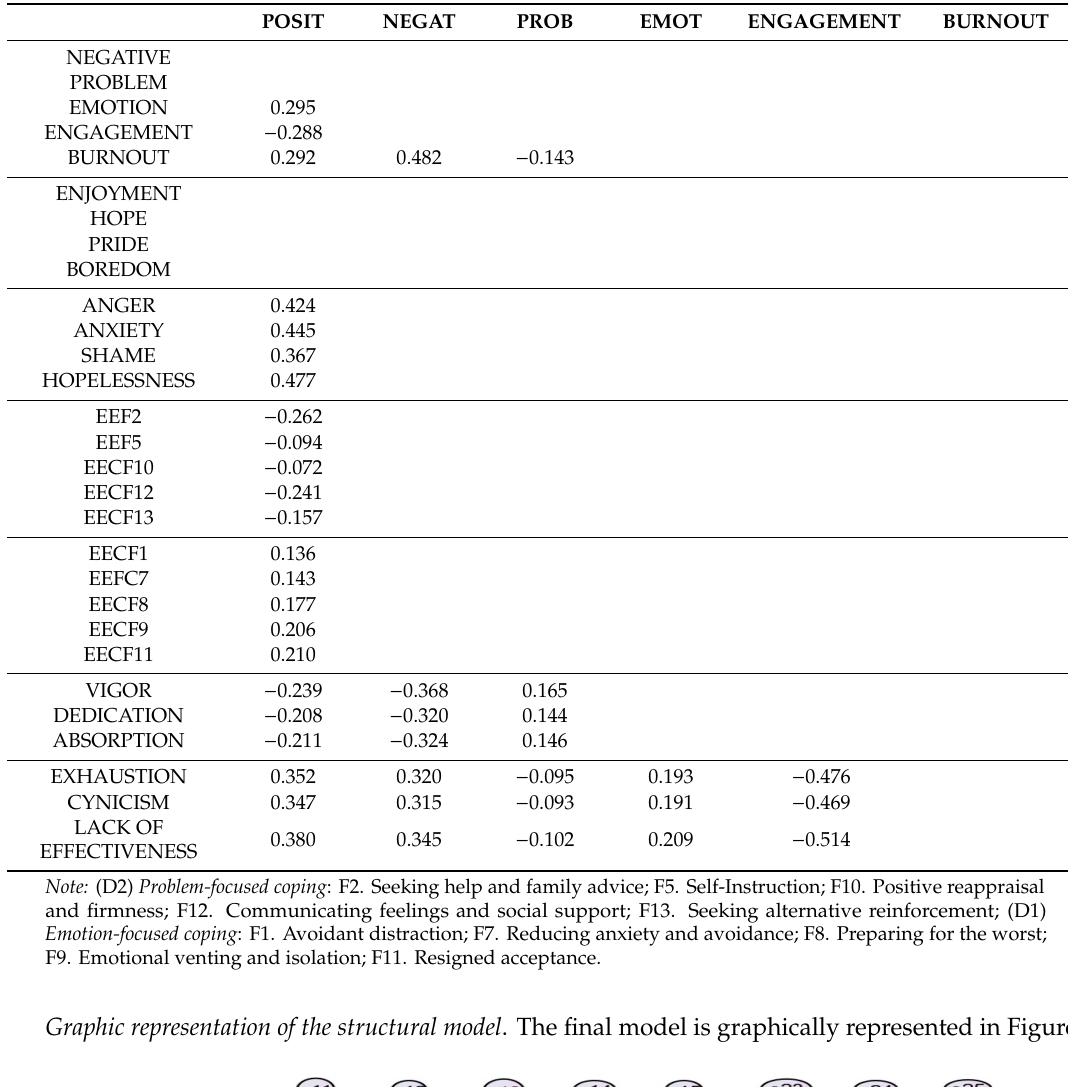
Table 5. Standardized Indirect E ff ects (Default model). Class Situation.